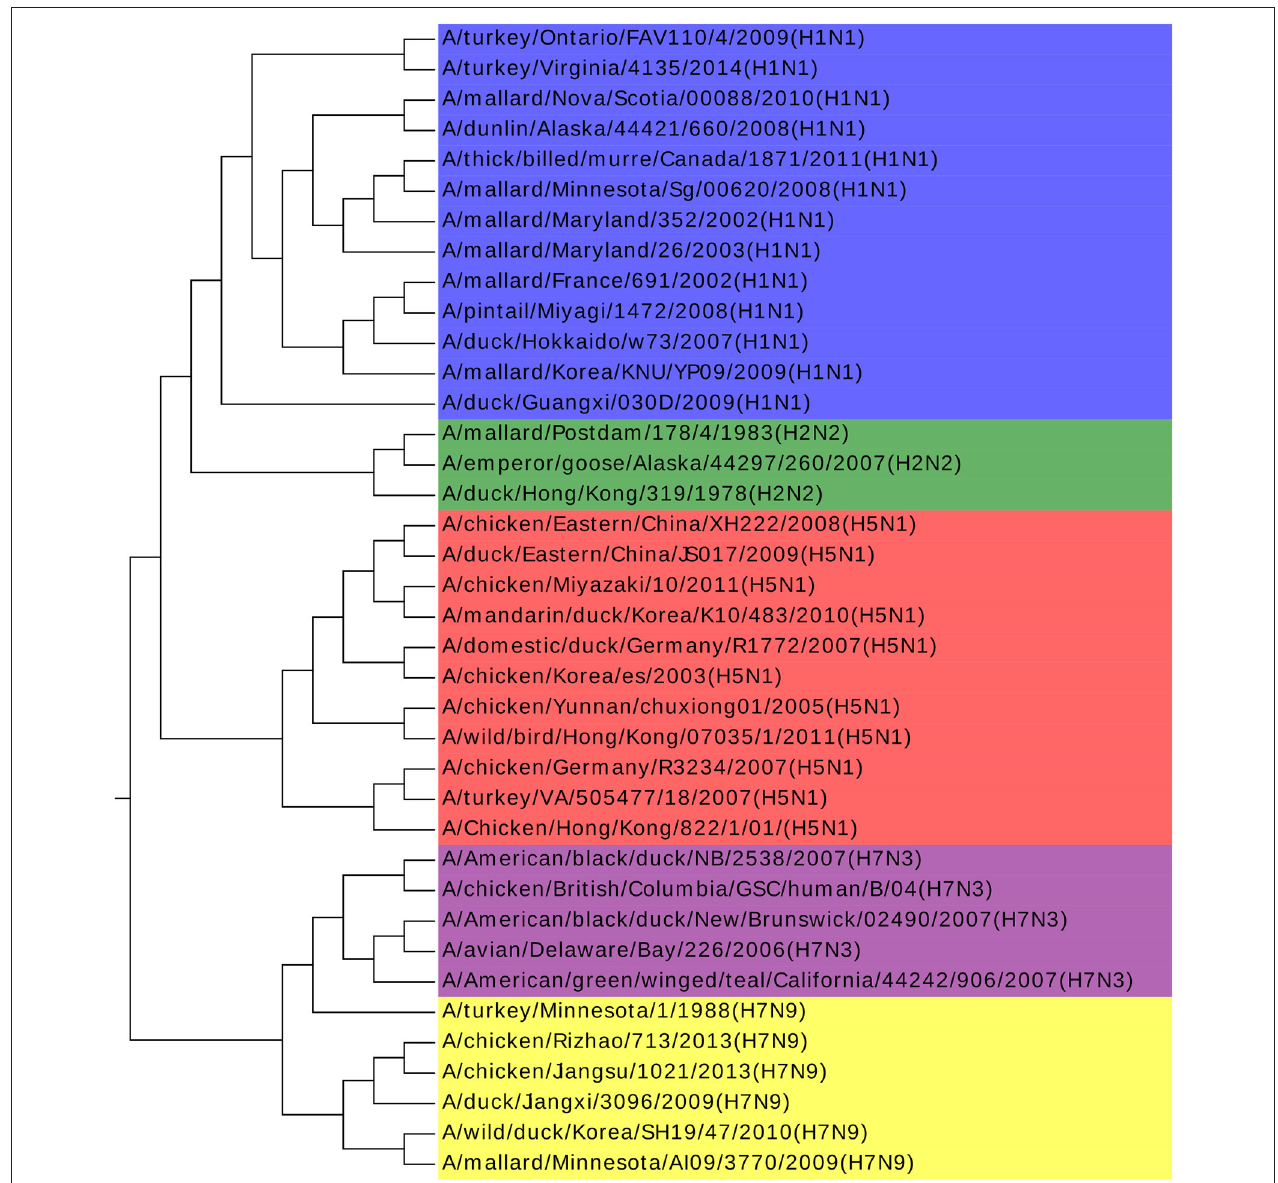
FIGURE 3 | The phylogenetic UPGMA tree using ANV method on Influenza A viruses